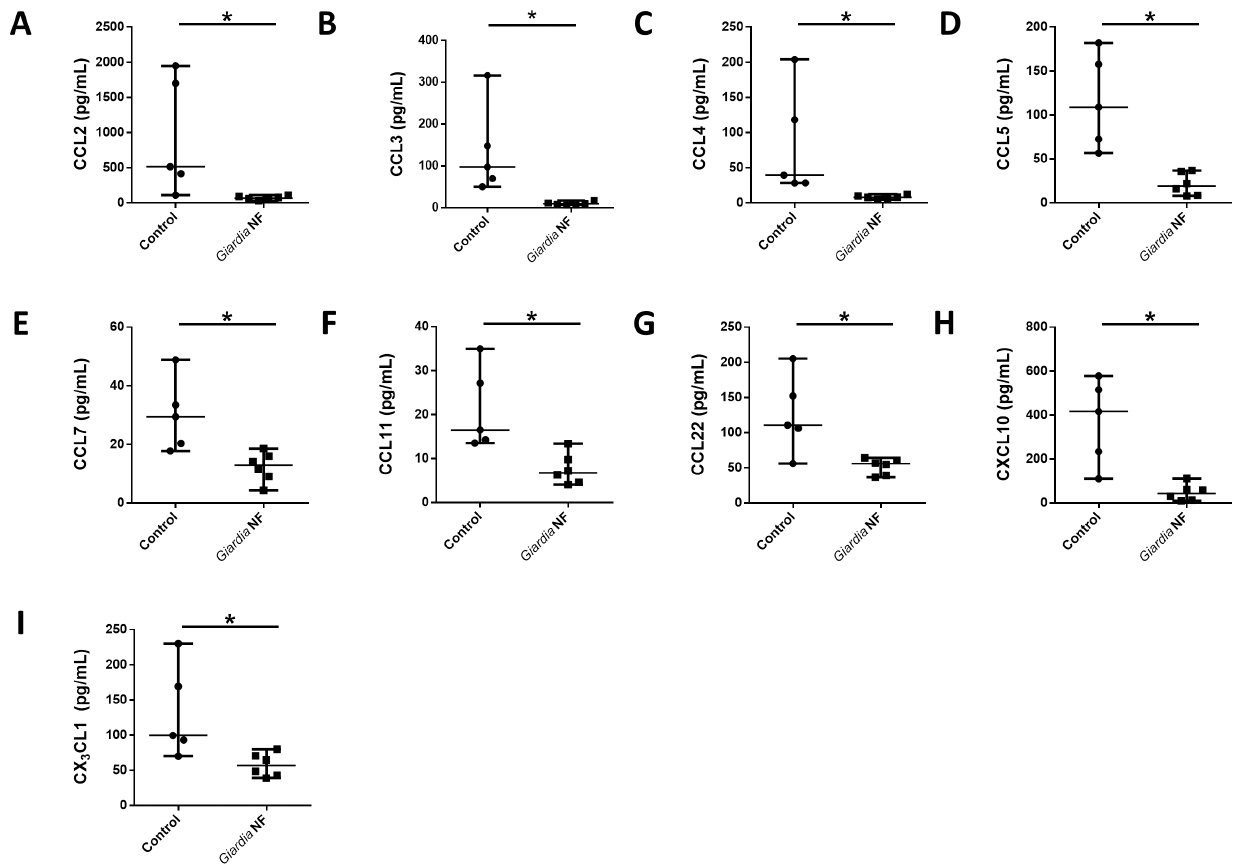
Figure 8. Giardia NF trophozoites attenuate the release of several chemokines from colonic mucosal biopsies. Human descending colon mucosal biopsy tissues obtained from areas of active inflammation from patients with active Crohn’s disease (CD) were incubated with 5.0 6 10 6 Giardia NF trophozoites for 6 hours. Supernatant levels of (A) CCL2, (B) CCL4, (C) CCL5, (D) CCL7, (E) CCL11, (F) CCL22, (G) CXCL10, and (H) CX 3 CL1 were determined via a bead-based cytokine assay. All data are representative of three independent experiments (n=4–6/group) and represented as median with the range. * p , 0.05. (Figure 2). In Giardia NF-infected animals administered intraco- lonically with 100 m g of TcdAB, colonic MPO activity (Figure 1B) and numbers of MPO-positive cells were lower when compared against control animals (Figure 2). Contrastingly, MPO activity levels (Figure 1C) and numbers of MPO-positive cells (Figure 2) in Giardia GS/M-infected animals intracolonically instilled with 100 m g of TcdAB were not significantly different from TcdAB- administered controls.